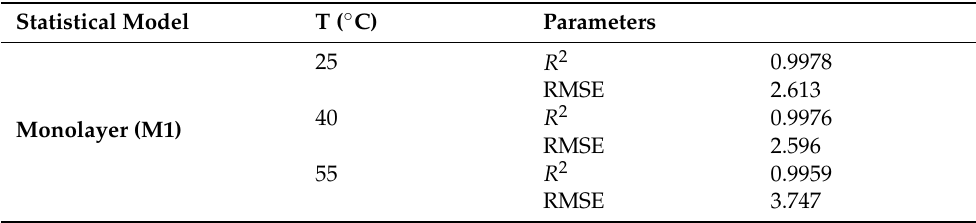
Table 4. R 2 and RMSE values for the tested advanced isotherms models for MB uptake by the BE/SD–MNPs